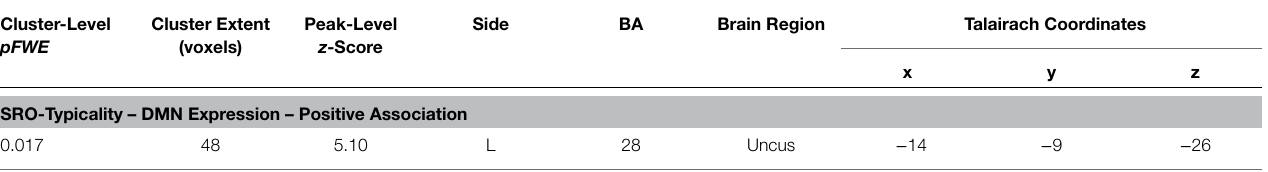
TABLE 3 | Significant findings emerged from the second set of inferential models. Cluster-Level